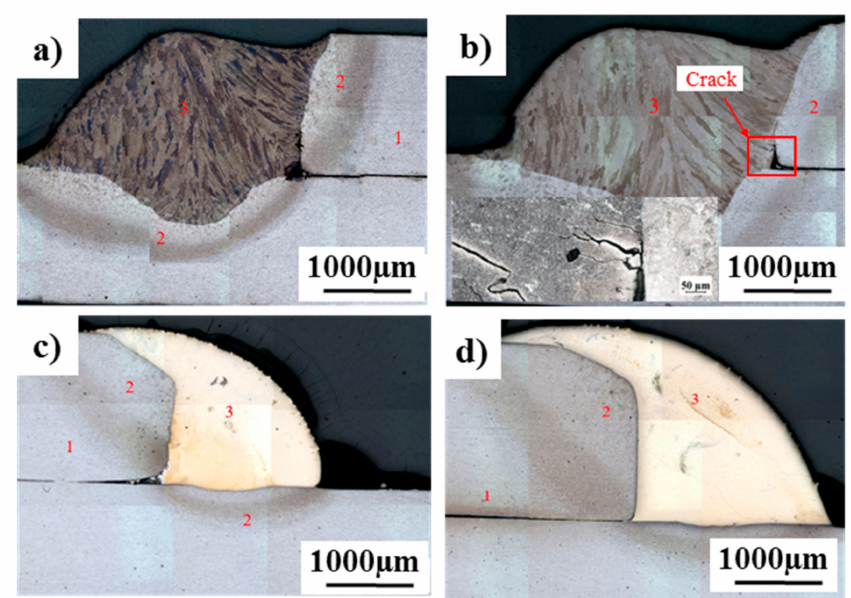
Figure 5. Macrostructural sections of welds. ( a ) GMAW-P low heat input, ( b ) GMAW-P high heat